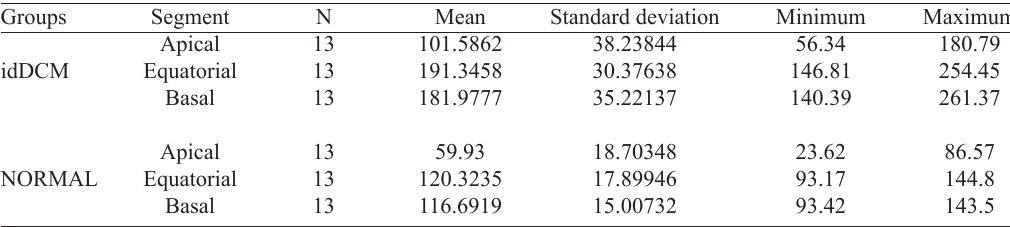
Table 2. Descriptive measures of variables apical, equatorial and basal perimeter in idDCM and NORMAL (mm) left ventricle